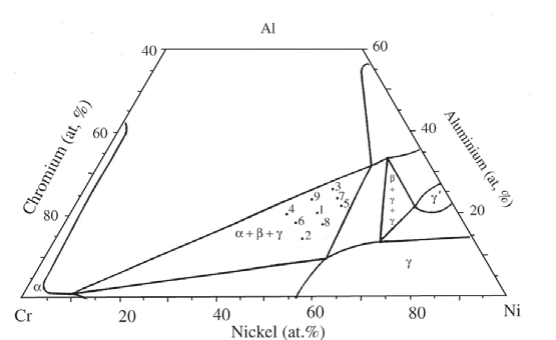
Figure 7. Isothermal section of Ni-Cr-Al 12 , showing schematic dif- fusion path for aluminium